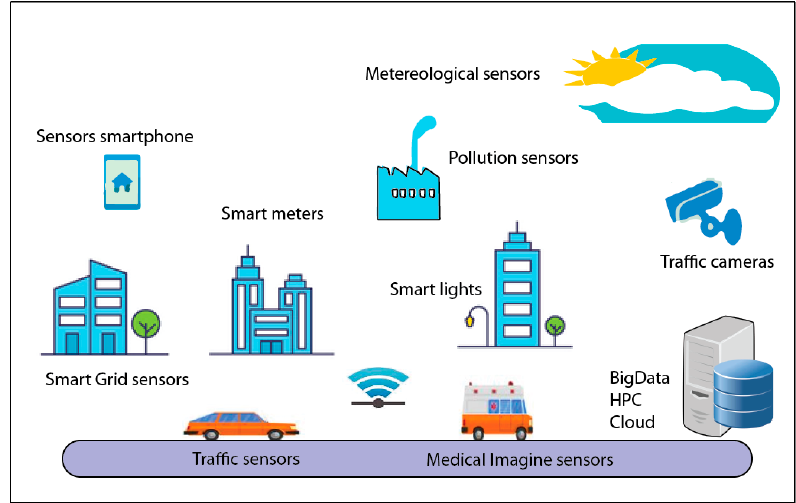
Figure 2. Sensorization and communication technologies (ICT) integration for the development of smart cities.